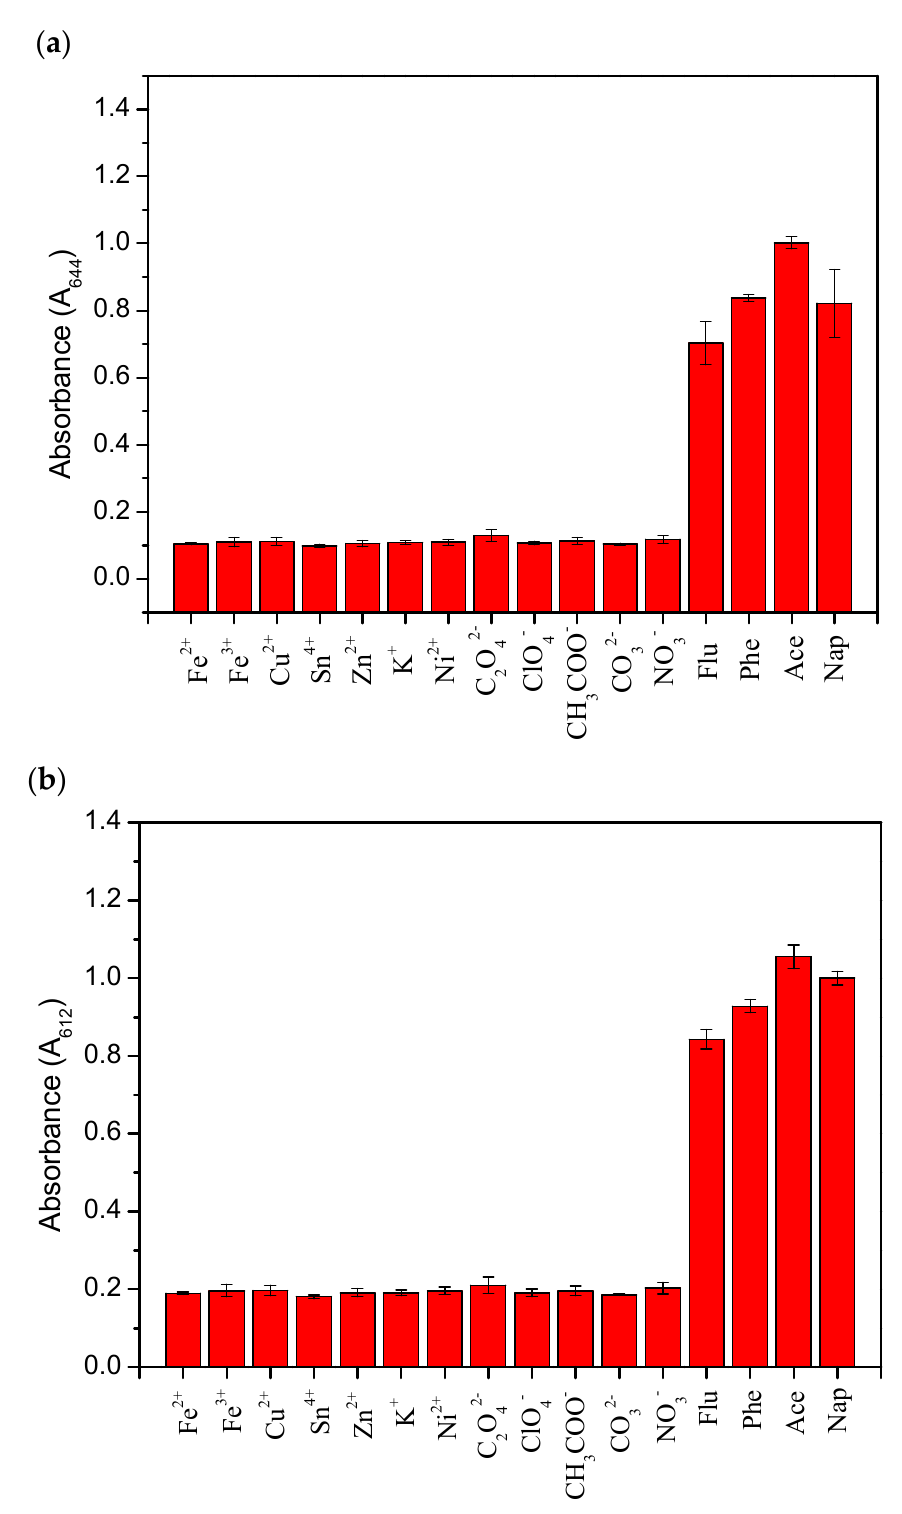
Figure 9. UV-vis absorbance of functionalized AuNPs in ( a ) the presence of Ace and other single ions and ( b ) the presence of Nap and other single ions.